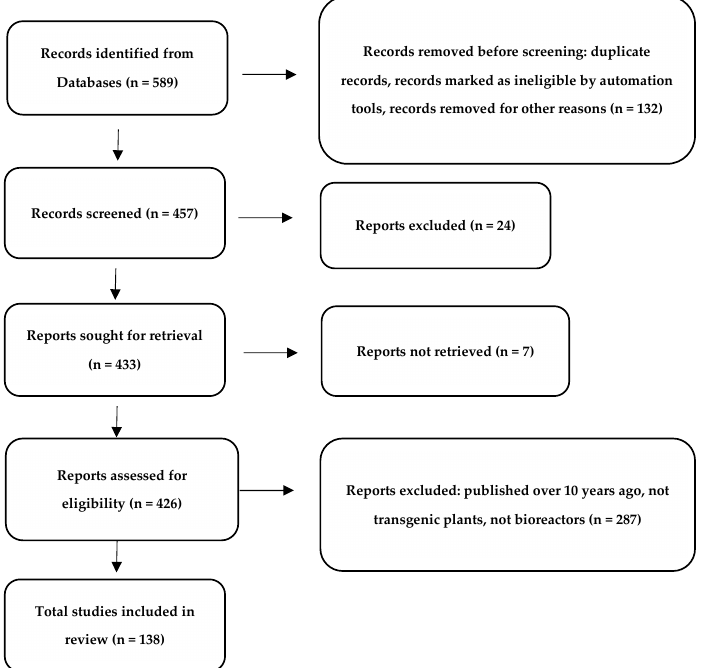
Figure 1. PRISMA flow diagram demonstrating the screening method for the article [32].